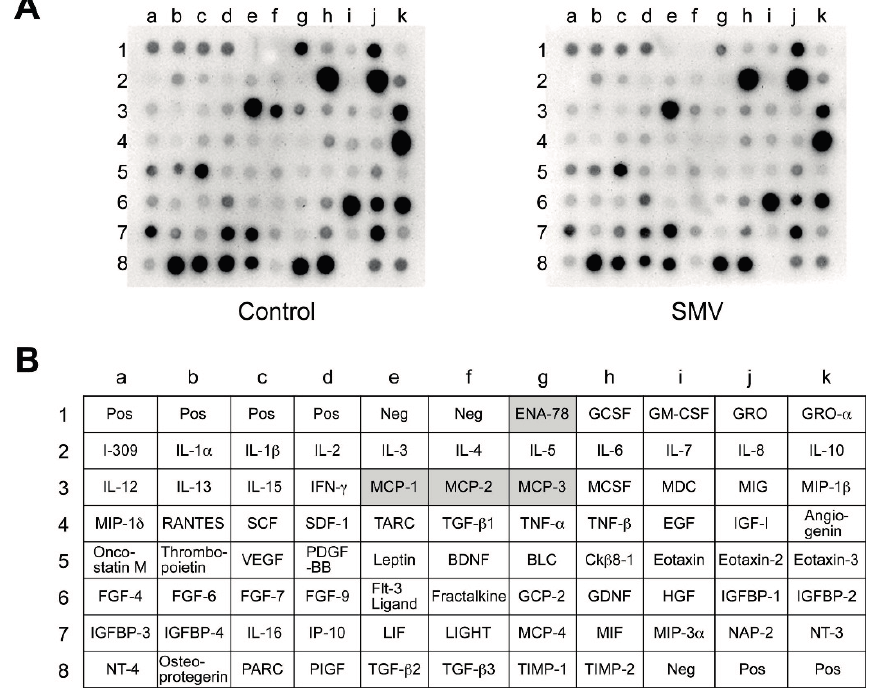
Figure 3. Array analysis of cytokines after statin treatment in human abdominal aortic aneurysm (AAA) wall. A human AAA wall was cut into small pieces and cultured with simvastatin (SMV, 10 μ M) or vehicle (control). The conditioned media were analyzed using a cytokine array. ( A ) Representative images are shown for array membranes; ( B ) the position of cytokines and controls on the membrane are listed. Highlighted cells indicate the cytokines downregulated after SMV treatment. Pos, positive control; Neg, negative